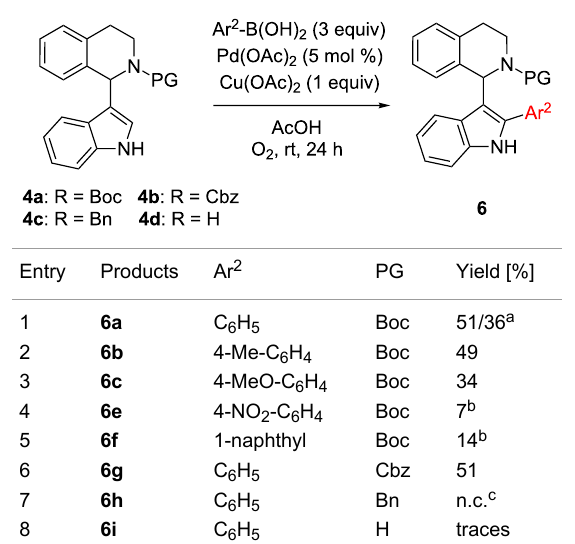
Table 2: Scope of palladium-catalyzed, regioselective C2-arylation of 1-(indol-3-yl)- N -PG-THIQ 4